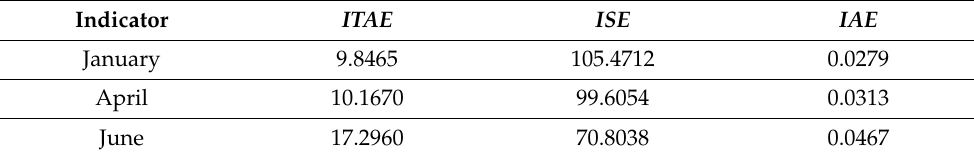
Table 1. Performance indicators in the north of Valle de Aburrá .